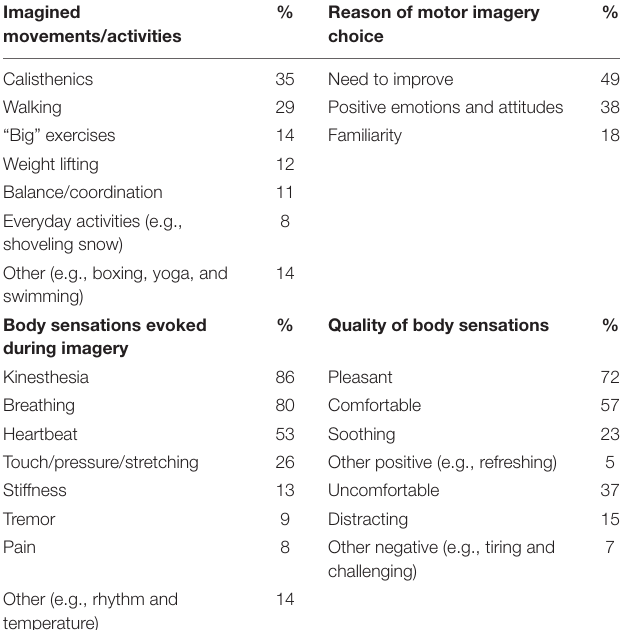
TABLE 2 | Summary of motor imagery diary